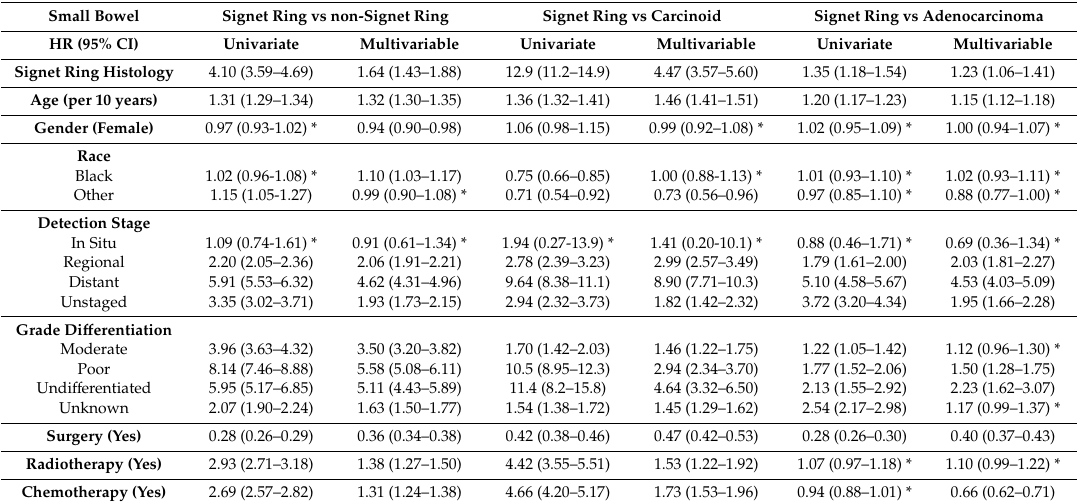
Table 22. Derived univariate and multivariable Cox-proportional hazard ratios (HR) of mortality for small bowel